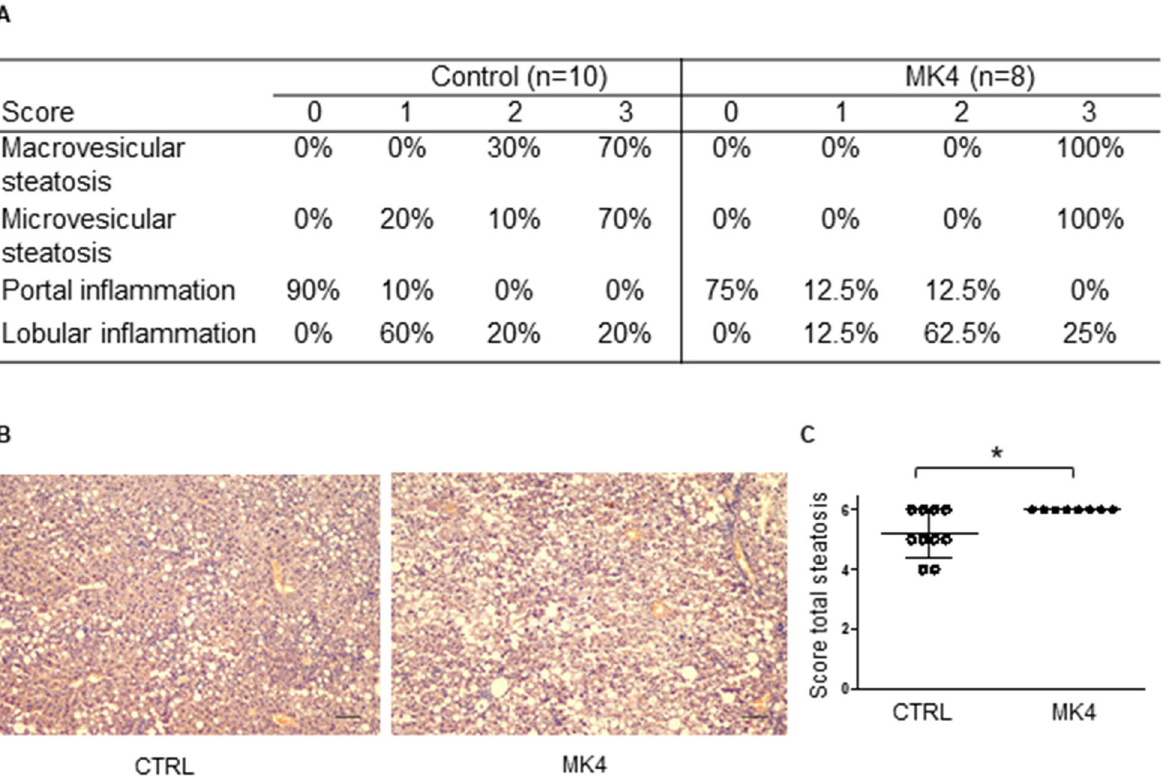
Figure 4. Hepatic effects of menaquinone 4 in LDLr −/− ApoB 100/100 mice. ( A ) Steatosis scoring of mice livers. Score 0: negative, score 1: mild, score 2: moderate, score 3: strong. ( B ) Representative images of liver histology with hematoxylin–eosin staining. ( C ) Combined score of micro- and macrovesicular steatosis. Scale bars are 200 µm. CTRL ( LDLr −/− ApoB 100/100 mice on Western diet (WD); MK4, LDLr −/− ApoB 100/100 mice on WD with menaquinone 4. Mann–Whitney U-test was used for statistical analysis. * p <